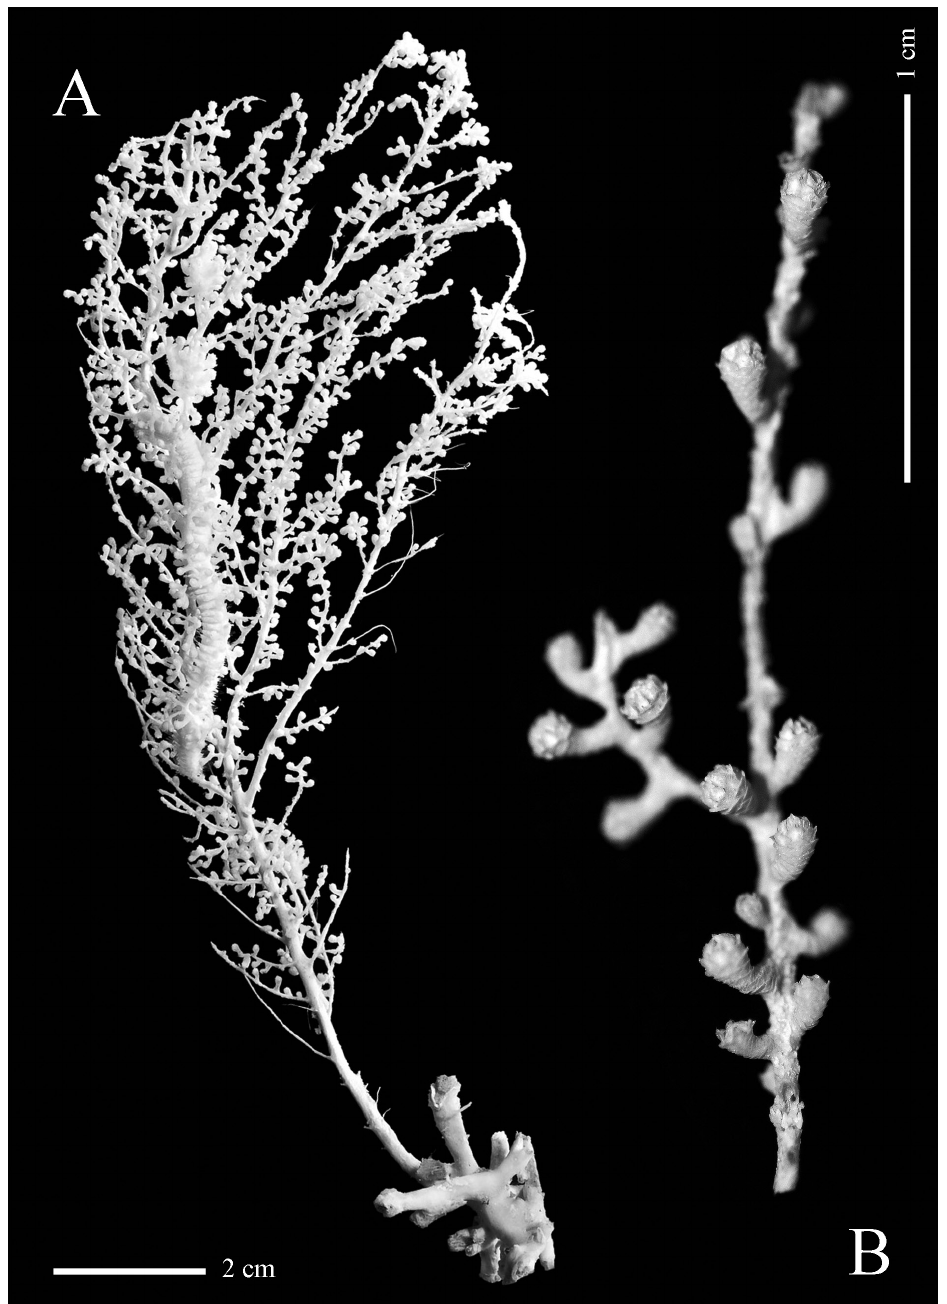
Fig . 10. – Thouarella grandiflora Kükenthal, 1912: A, holotype (ZMB Cni 5469), whole colony, [photo: Carola Radken, ZMB, Berlin]; B, paralectotype (MPUW 44), detail of Coenenchymal sclerites (Fig. 9D) round in shape, 0.12-0.28 mm maximum length. Inner surface with scattered tubercles, outer surface slightly smooth with some granules, margin finely serrated.